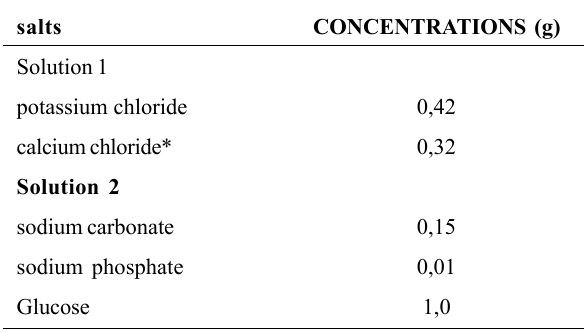
* Anidous and hydrate Dilution: 50 ml of solution 1 (chlorides) and 50 ml da solution 2 (carbonates) – completed to 1000